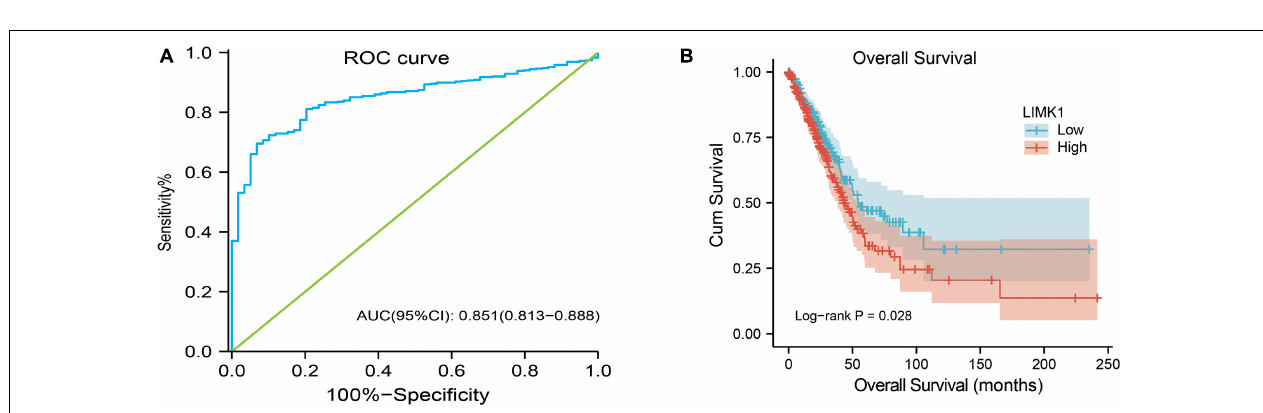
Frontiers in Genetics |